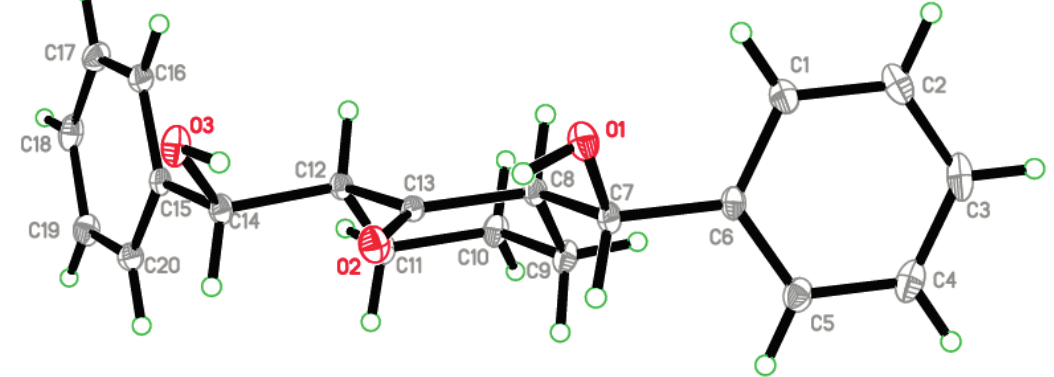
Figure 2. ORTEP diagram of the compound 1 drawn at 50%; ellipsoids showing the chair conformation of cyclohexanone ring.